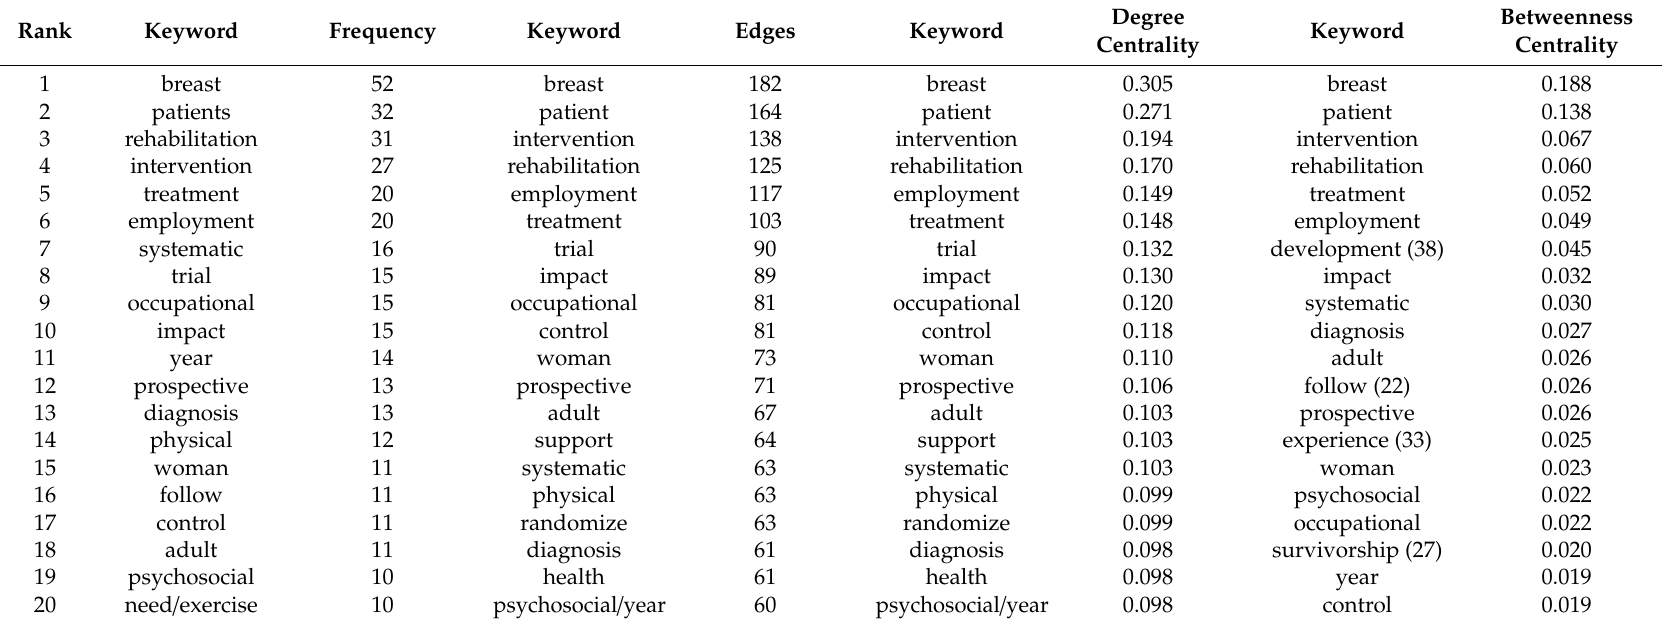
Table 1. Top 20 core keywords in the research